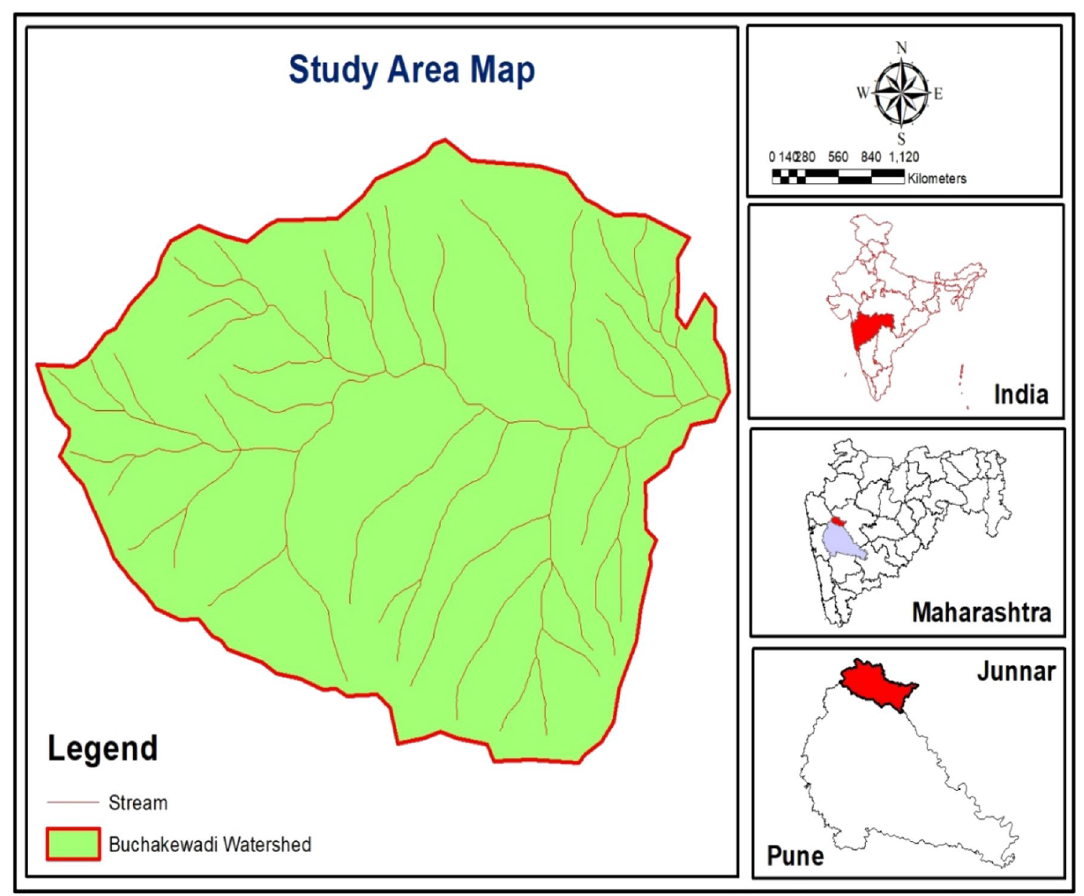
Fig. 2 Location map of study